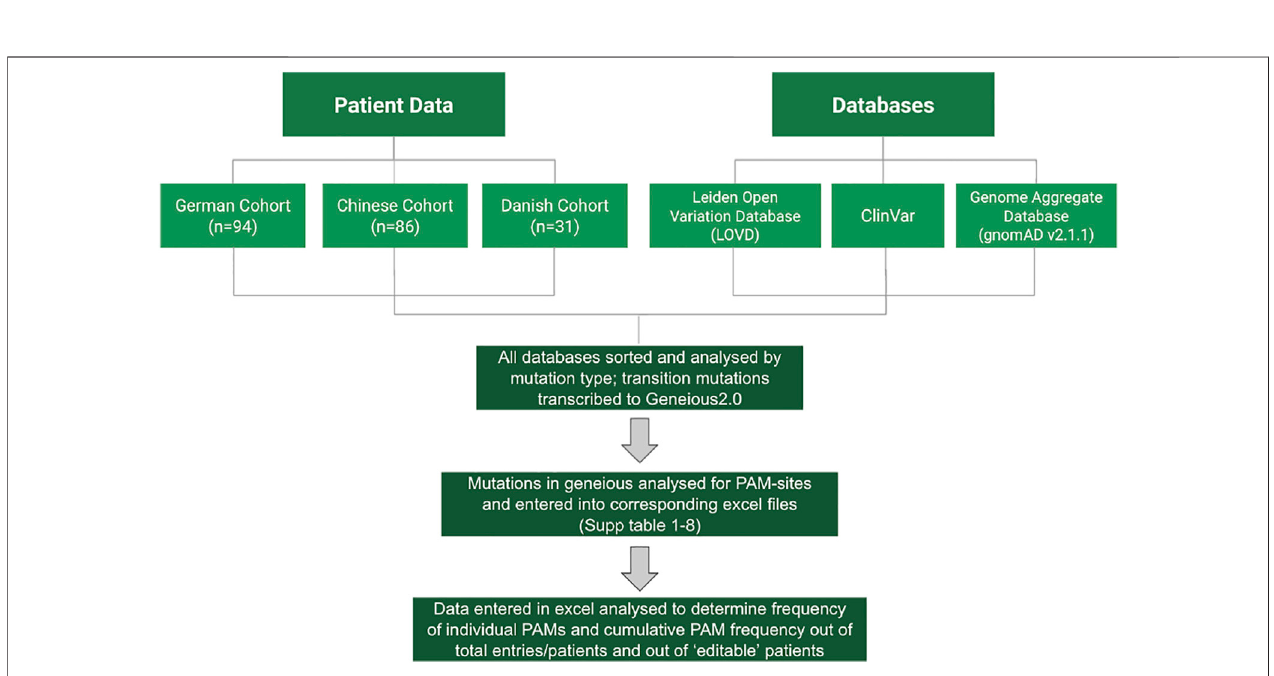
FIGURE 2 | Flow chart of the different data used and the analysis process.